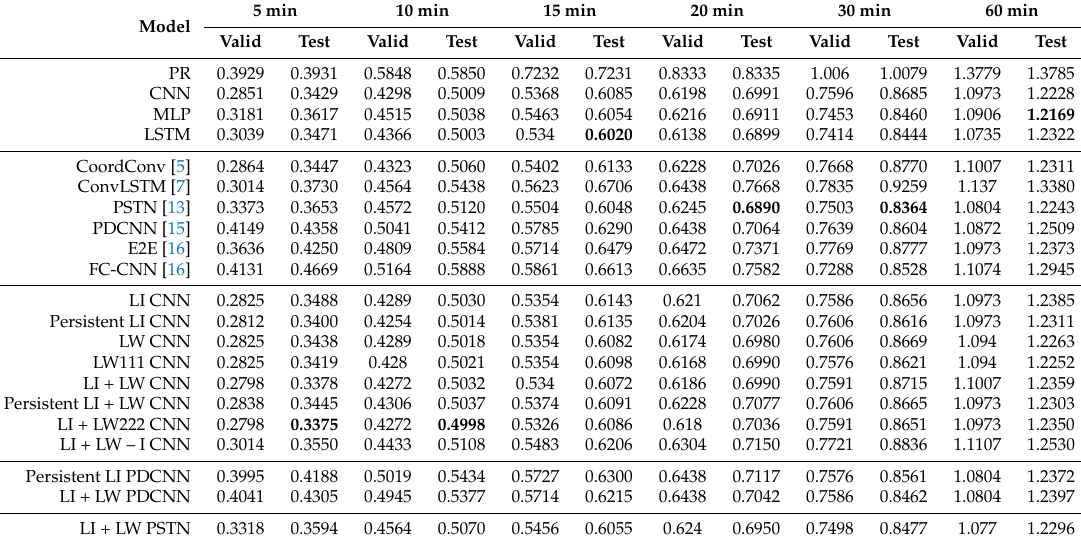
Table 2. RMSE results of different models and prediction horizons on the WIND dataset. Best testing results are indicated in